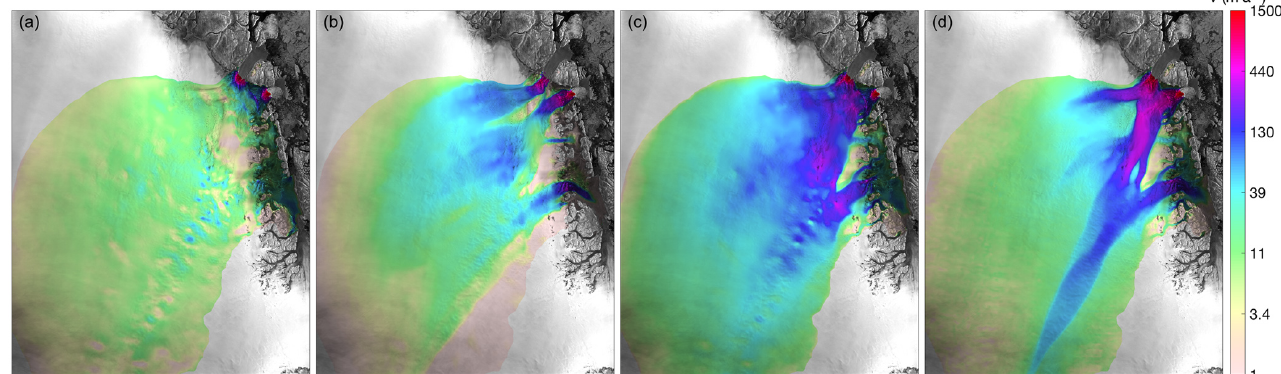
Figure 9. Horizontal surface velocity: ISSM with reduced ice overburden pressure N HUY (a) , PISM result from Aschwanden et al. (2016), interpolated to unstructured ISSM grid (b) , ISSM with effective pressure from our hydrology model N CUAS (c) , and observed velocities (Rignot and Mouginot, 2012) (d)